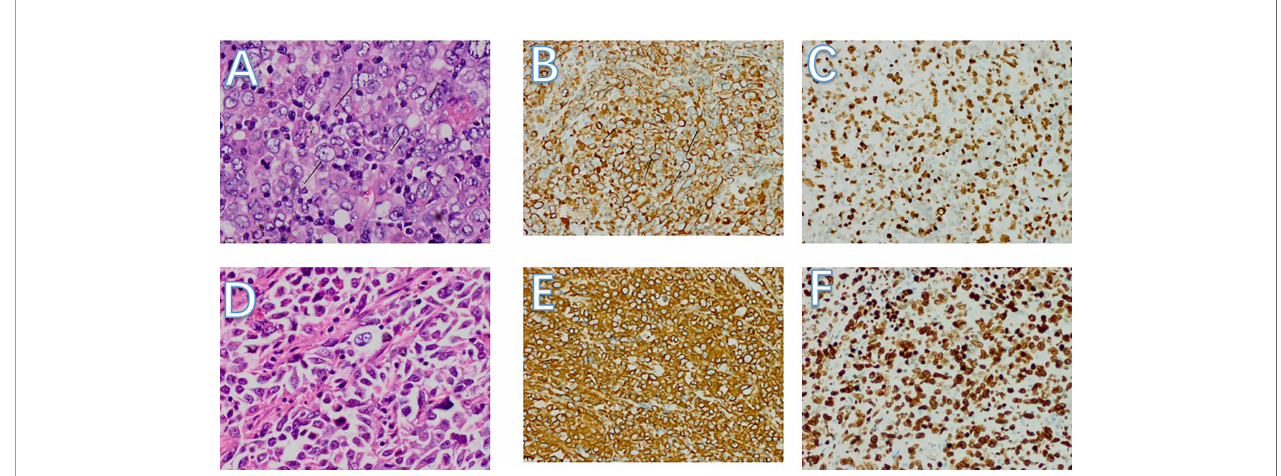
FIGURE 5 | (A-C) Pathology of left lung mass. (A) Pulmonary tumors with cytologic atypia,different nuclear sizes. Most of the nuclei are vacuolated, some nucleoli can be seen, and mitotic fi gures are obvious (HE, 400x). (B) Diffuse cytoplasmic positivity in tumor cells (Vimentin 200x). C:tumor cells are nuclear-positive, showing a hyperproliferative state. (ki67 200x) (D-F) Pathology of small bowel mass. (D) Small bowel tumors with different nuclear sizes. Most of the nuclei are vacuolated, some nucleoli can be seen, and mitotic fi gures are obvious (HE, 400x). (E) Diffuse cytoplasmic positivity in tumor cells (Vimentin 200x). (F) Tumor cells are nuclear- positive, showing a hyperproliferative state. (ki67